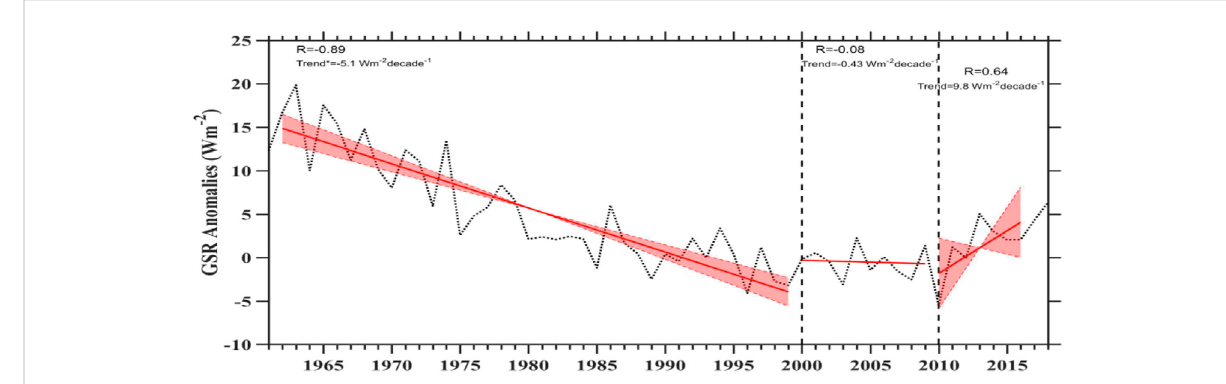
FIGURE 2 Timeseriesofthearea-weightedaverageofyearlyGSRanomaliesbasedon36stationsineasternChinaduring1961 – 2018. “ R ” isthecorrelation coef fi